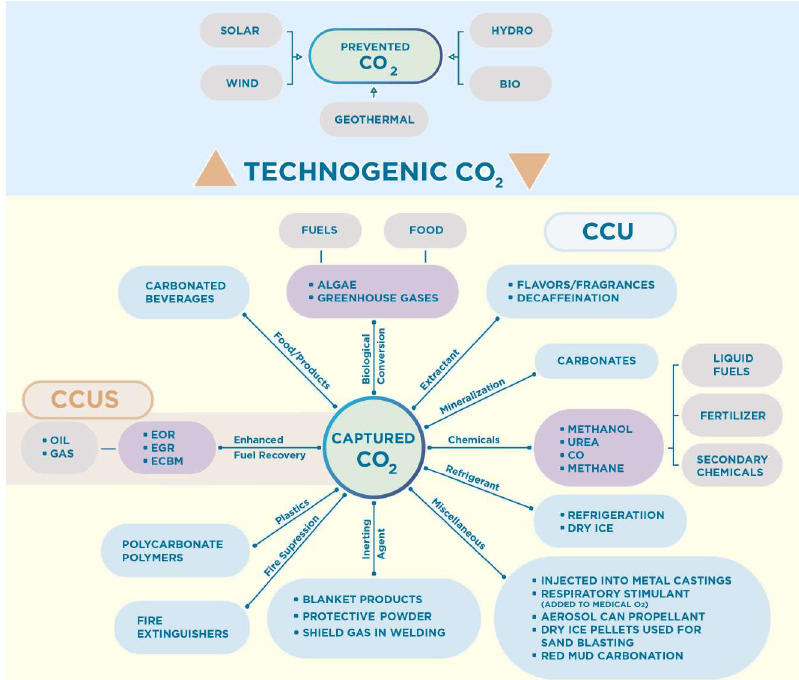
Figure 3. Cluster of Carbonless and Low-Carbon Technologies. Acronyms: CCUS—Carbon Capture, Utilization and Storage, CCU—Carbon Capture and Utilization, EOR-Enhanced Oil Recovery, EGR—Enhanced Gas recovery, ECBM—Enhanced Coal Bed Methane